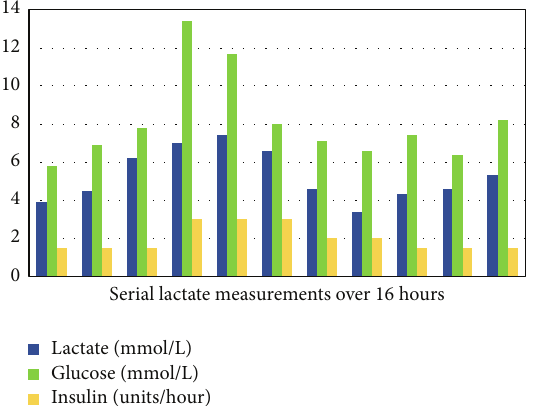
Figure 1: Persistent lactic acidosis with dextrose and insulin therapy in an 18-year-old female patient with hepatomegaly.